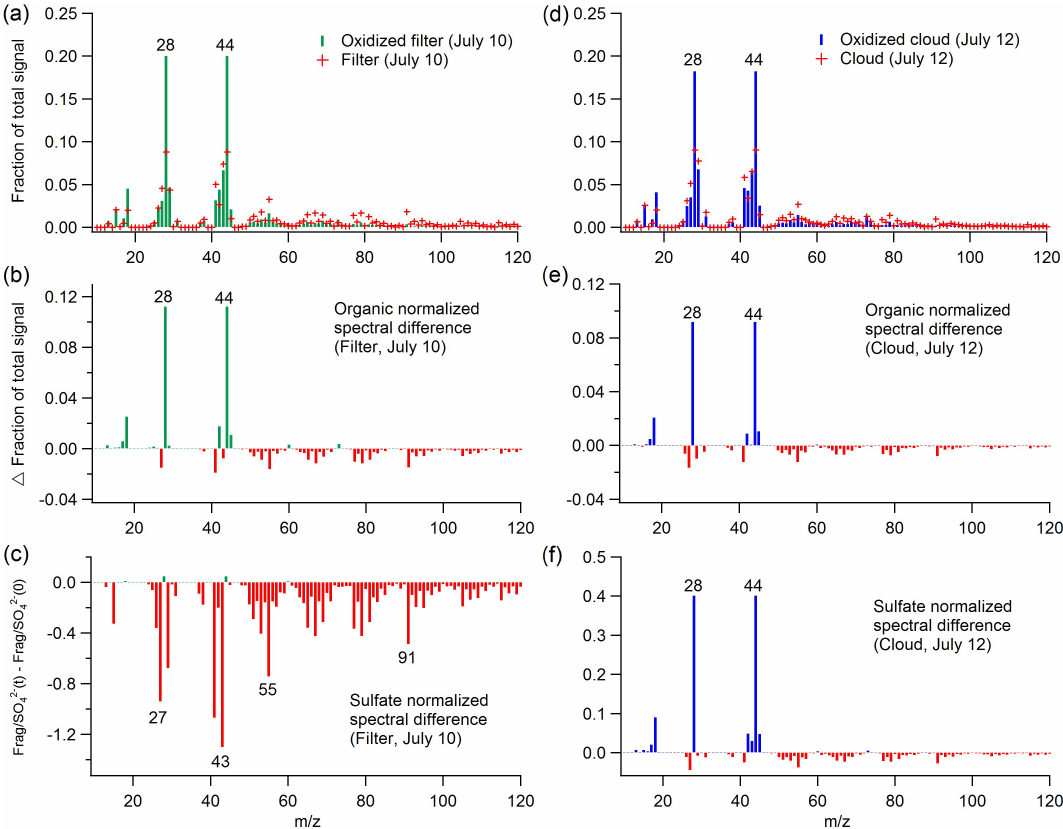
Fig. 4. Top spectra: AMS organic spectra of (a) aerosol filter extracts and (d) cloud water before and after aqueous-phase OH oxidation. Middle spectra: Spectral difference between the AMS organic spectra (normalized by AMS organics mass) of oxidized and un-oxidized (b) aerosol filter extracts and (e) cloud water. Bottom spectra: Spectral difference between the AMS organic spectra (normalized by sulfate mass) of oxidized and un-oxidized (c) aerosol filter extracts and (f) cloud water. Negative values (red) shown in (b) , (c) , (e) and (f) indicate that the mass fragments were consumed due to aqueous-phase OH